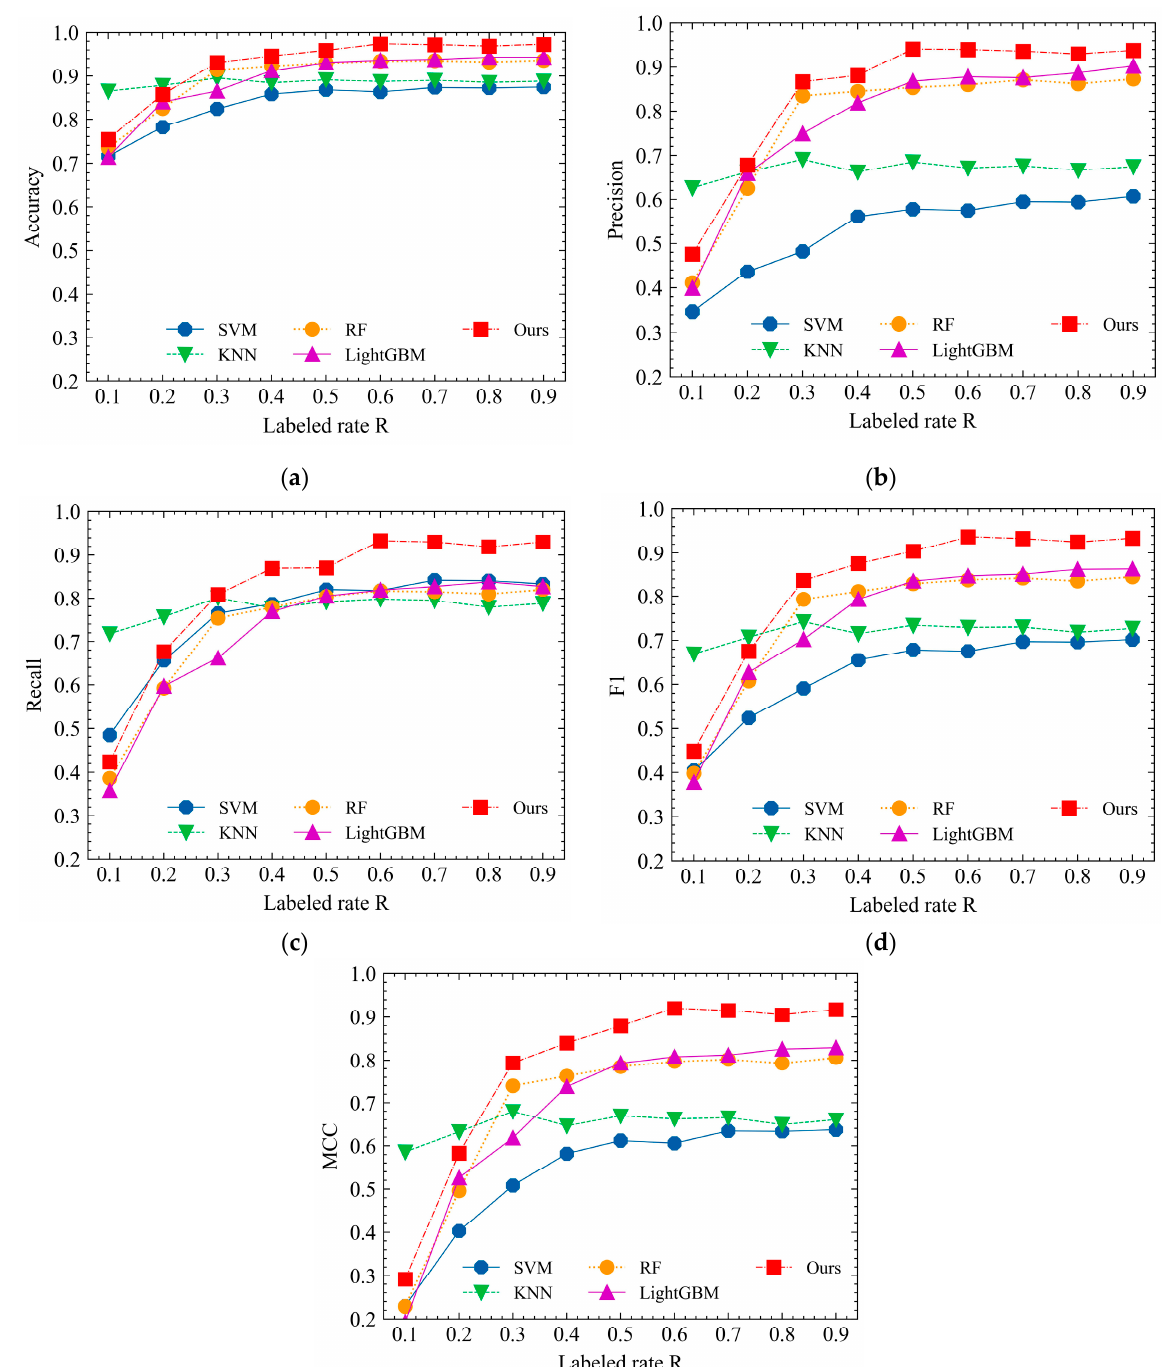
Figure 7. Classification results of different base classifiers using the tri-training algorithm. ( a ) Accu- racy; ( b ) Precision; ( c ) Recall; ( d ) F1; ( e ) MCC.